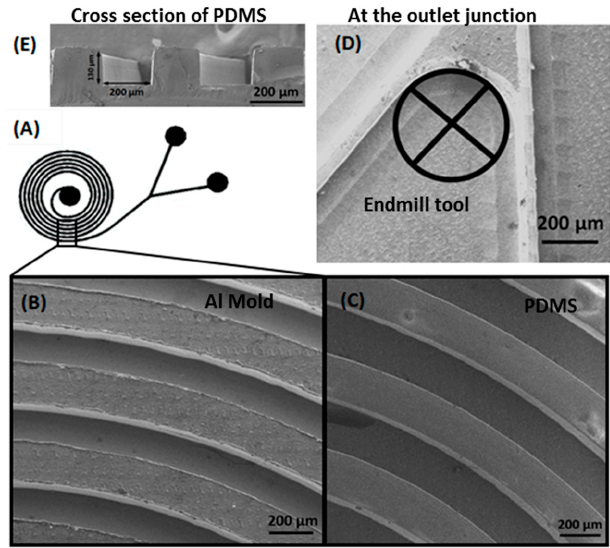
Figure 6. ( A ) Schematic of Spiral structure; ( B ) SEM micrograph of the aluminium mold; ( C ) SEM micrograph of the casted PDMS channel from the mold; ( D ) Outlet intersecting junction; ( E ) Cross section image of the PDMS channel.